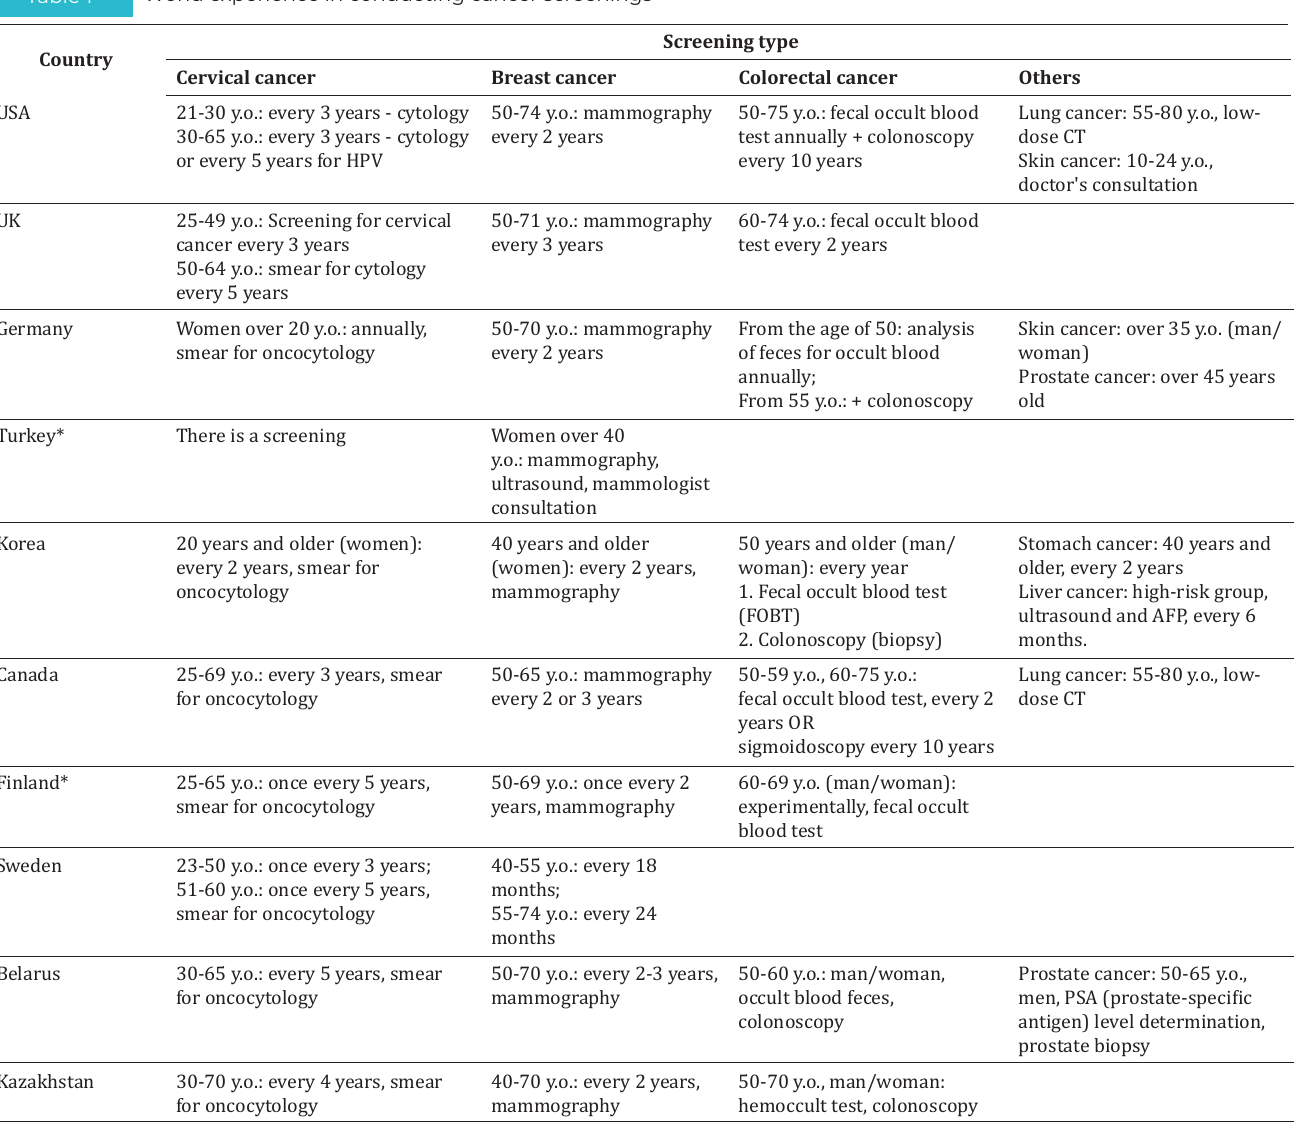
World experience in conducting cancer